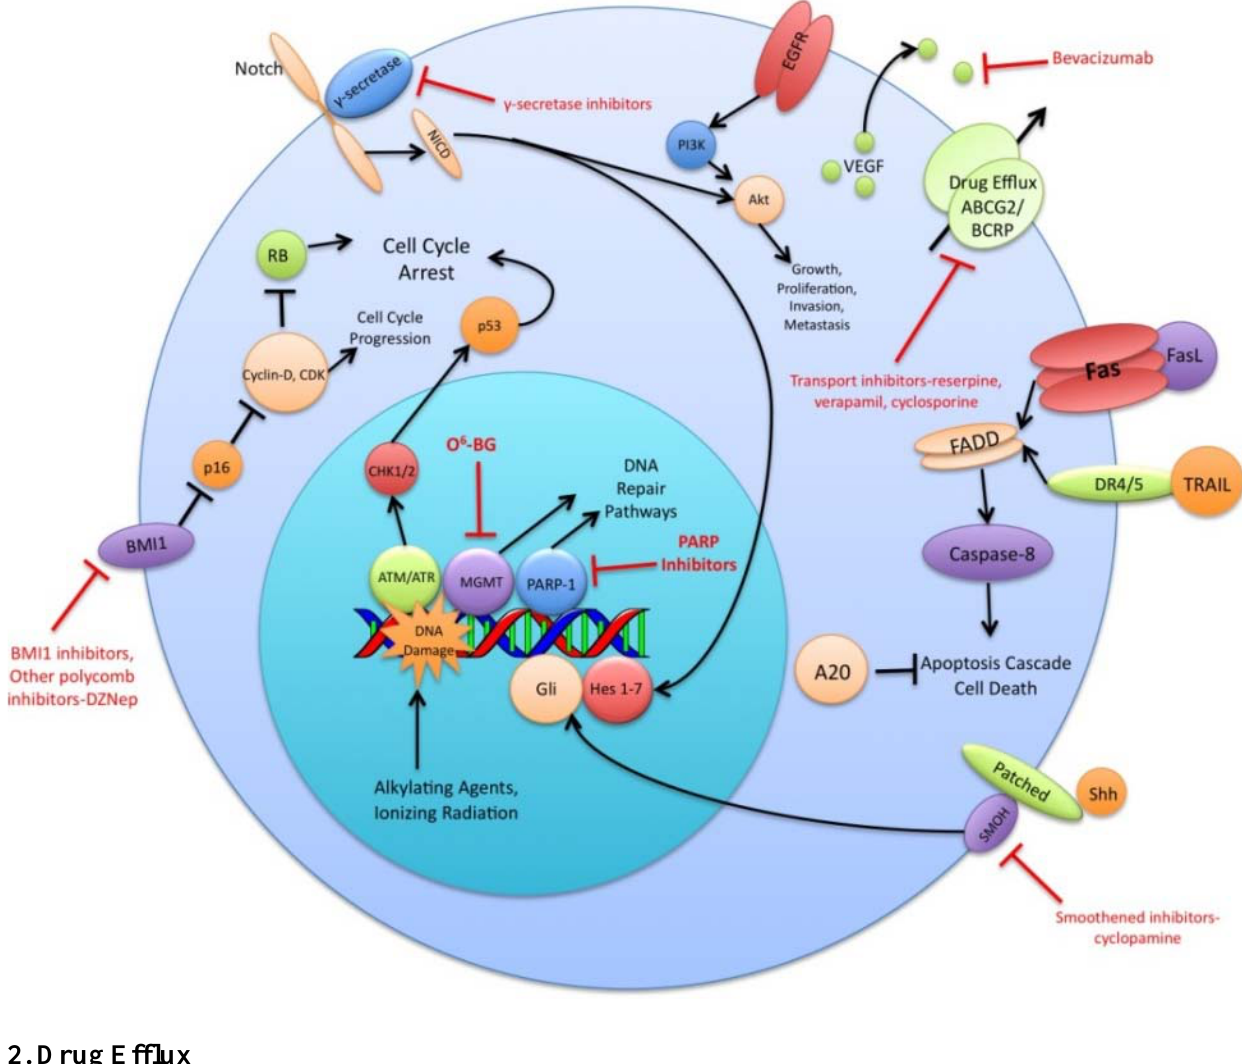
Figure 1. Mediators of TSC treatment resistance. Depicted are the various treatment resistance mechanisms and pathways differentially expressed or regulated in TSC versus their differentiated cell counterparts. Blocked red lines indicate ways to inhibit or block these